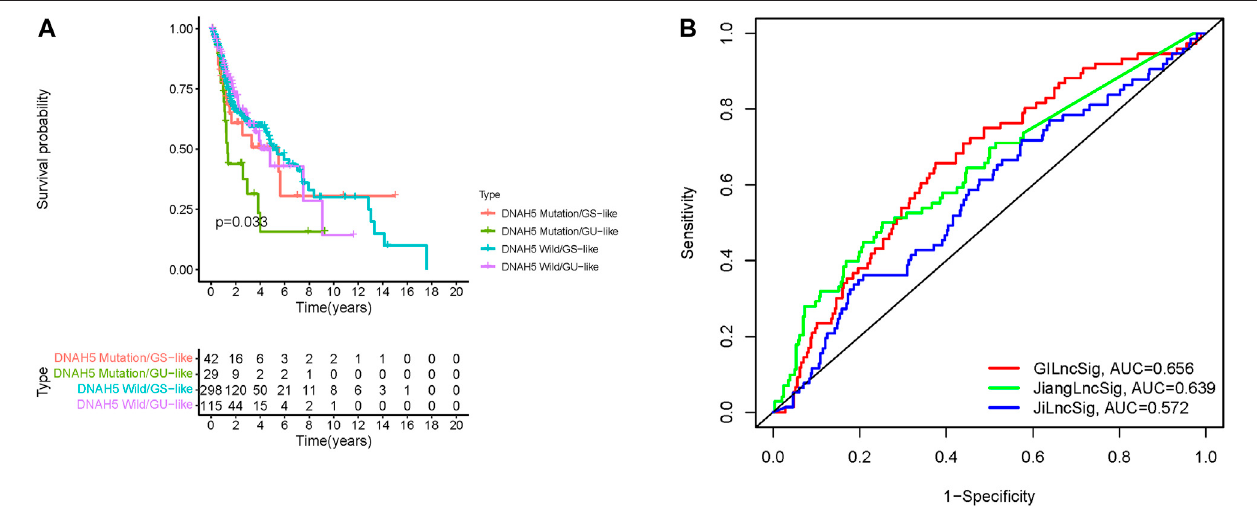
FIGURE7| RelationshipbetweentheGILncSigandDNAH5somaticmutationandmodelcomparison. (A) Kaplan-Meiercurveanalysisofoverallsurvivalofpatients withDNAH5mutantorwild-typestatusforthecombinedGS-likeandGU-likegroups. (B) Time-independentreceiveroperatingcharacteristiccurvesofoverallsurvivalfor GILncSig, Jiang ’ s LncSig, and Ji ’ s LncSig. GILncSig, genomic instability-associated lncRNAs signature; DNAH5, dynein axonemal heavy chain 5.